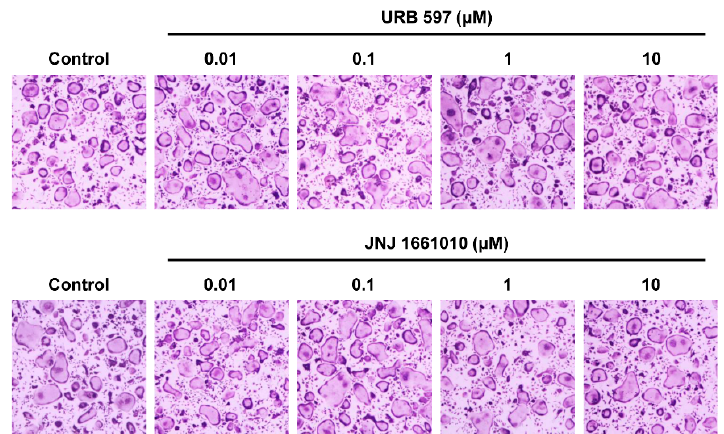
Figure 6. The effect of two other fatty acid amide hydrolase (FAAH) inhibitors, URB597 and JNJ1661010, on osteoclast differentiation. BMMs were cultured in an osteoclastogenic medium with the vehicle or several concentrations of FAAH inhibitors, URB597 ( upper panel), or JNJ1661010 ( lower panel). The cells were stained for TRAP.